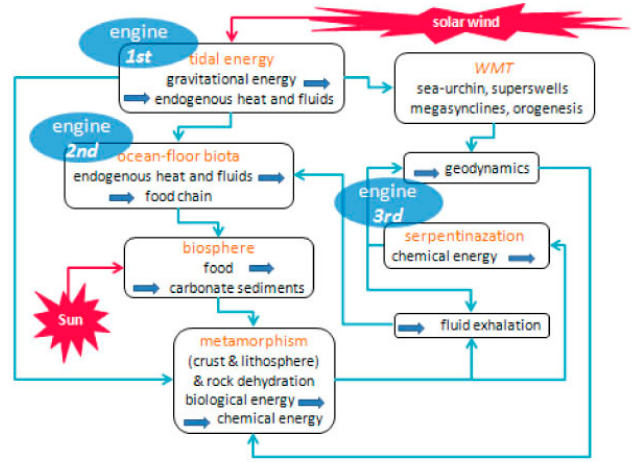
Figure 9. The leading drivers of “climate” are three engines. The Sun, through the solar wind, modulates the physical engine (i.e., the TD dynamo), and through solar irradiance amplifies the role of the food chain by fluids and energy exhaled from soil. The generated biomass finally returns into ground in the form of organic sediments. After Gregori (2015) [14].